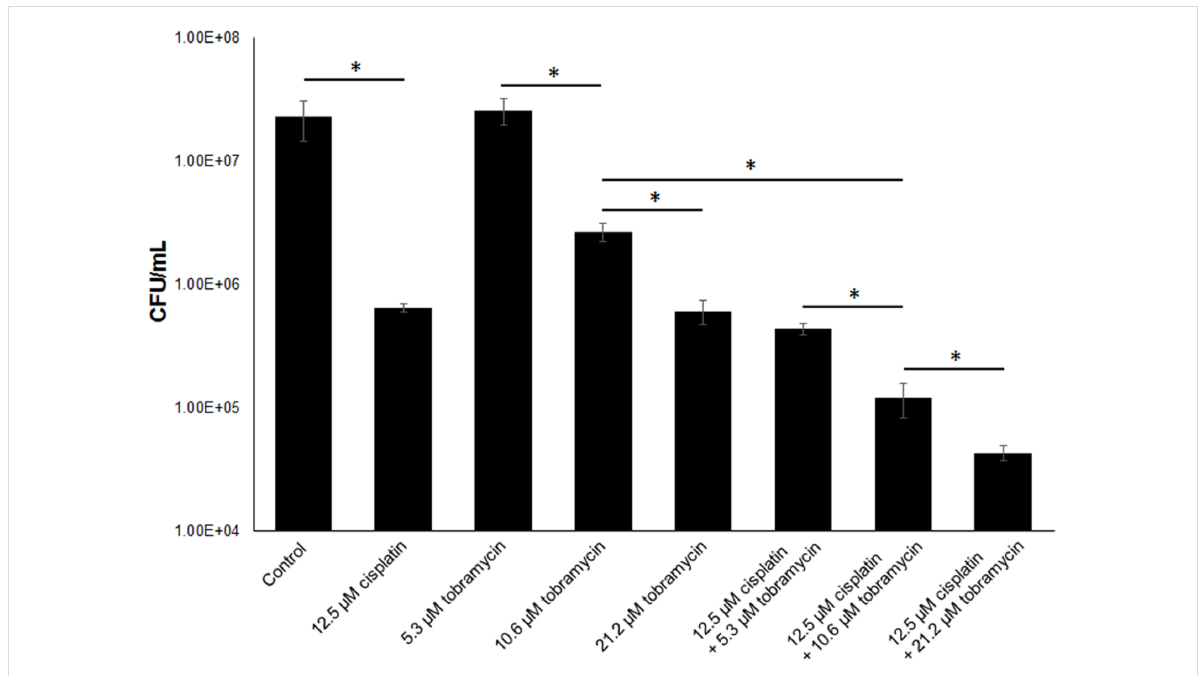
Figure 6: P. aeruginosa biofilm killing assay by cisplatin, tobramycin and their combinations. P. aeruginosa biofilms were treated by ABTGC medium with varies concentrations of cisplatin and or tobramycin for 4 h. CFUs were determined for cisplatin and or tobramycin-treated P. aeruginosa biofilms. Means and s.d. from triplicate experiments are shown. Student’s t-test was performed for testing differences between groups. * P ≤ 0.05.